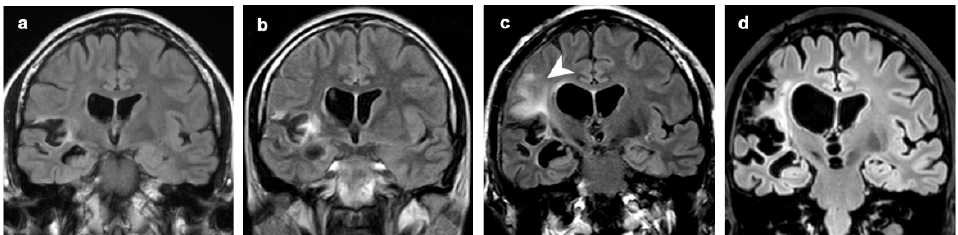
Figure 6. Patient 8, hyperintense signal intensities that preceded focal atrophy. Coronal FLAIR images at ( a ) 3 years, ( b ) 4 years, ( c ) 8 years and ( d ) 18 years from clinical onset. Focal atrophy limited to right perisylvian and insular region at the first MRI scan was followed by hyperintense alteration both of GM and WM in insula and frontal lobe ( b , c , arrowhead). These alterations preceded worsening of the atrophic changes in the same areas.